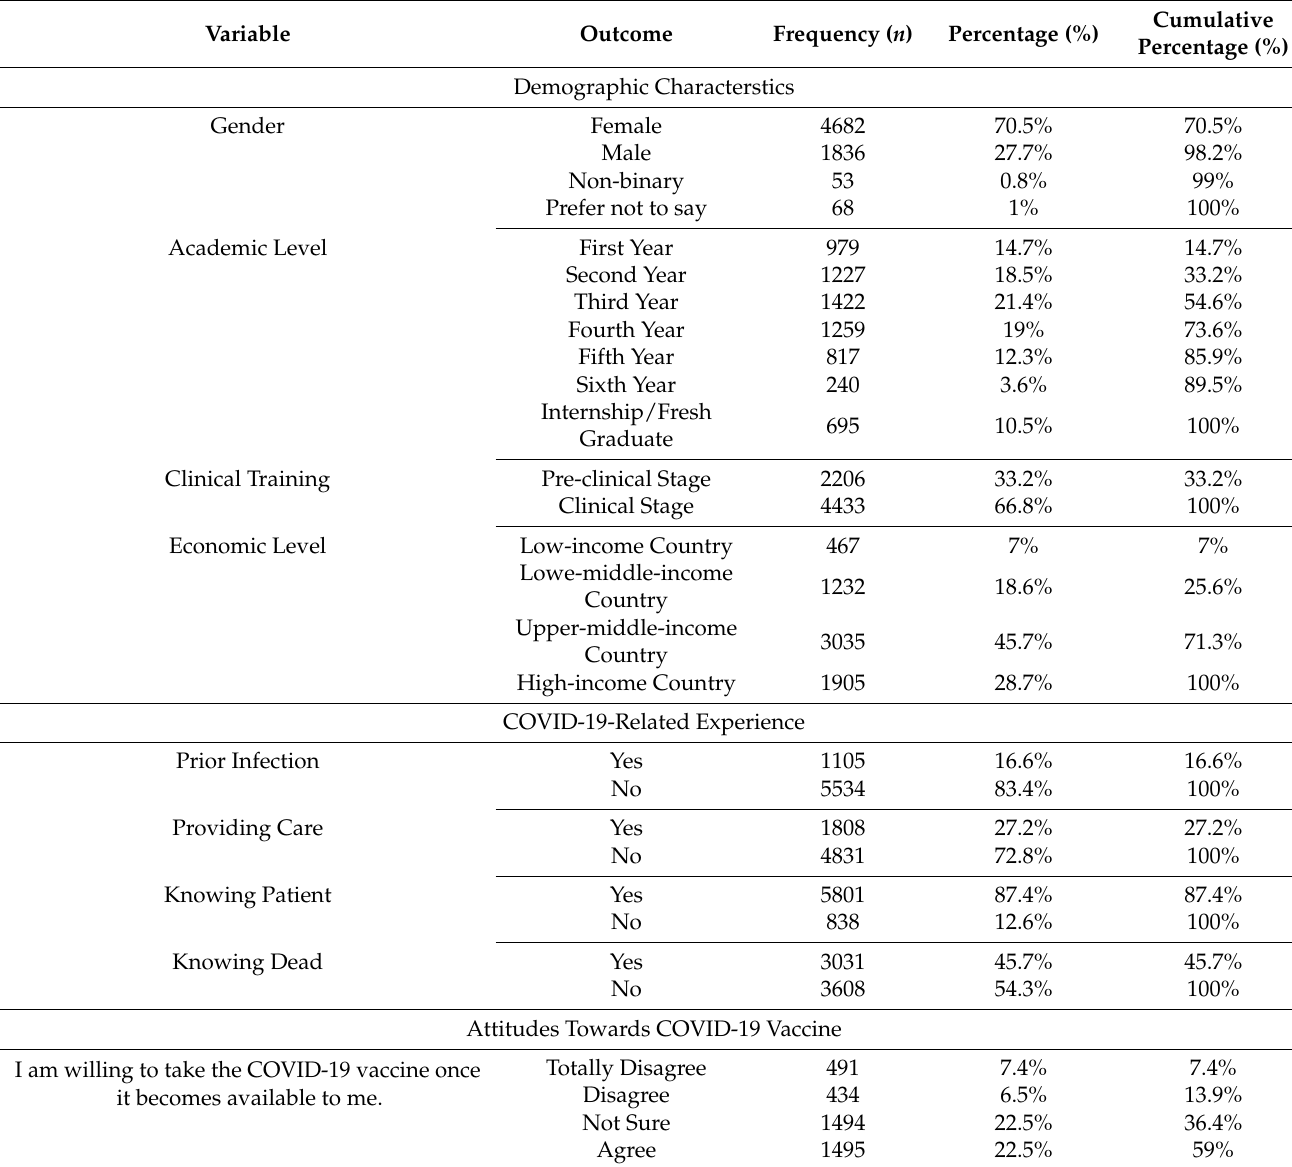
Table 3. Demographic characteristics, COVID-19-related experience, and COVID-19 vaccine willingness and its drivers among a global sample of dental students, February 2021 ( n =